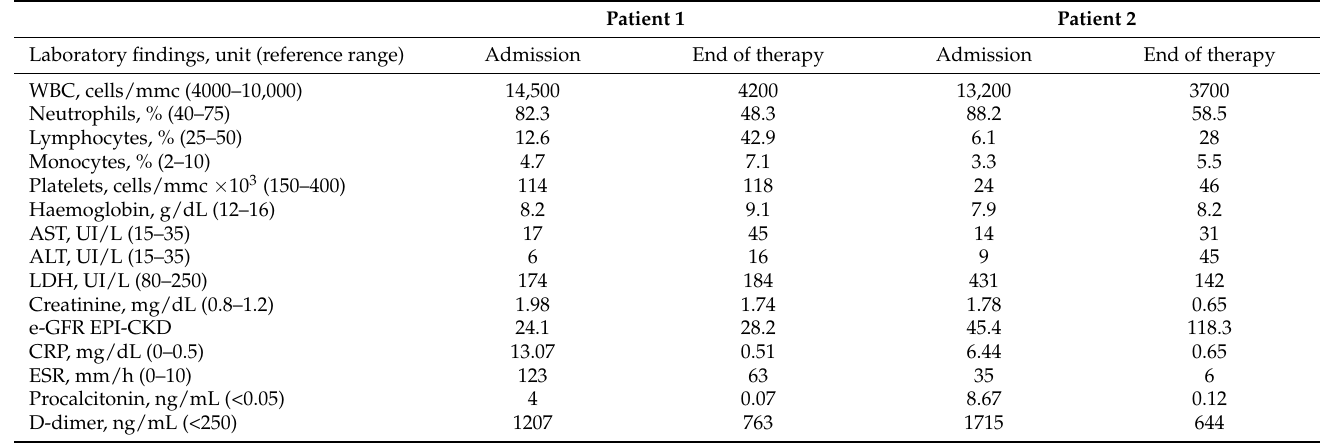
Table 1. Laboratory findings at admission and after antibiotic treatment. WBC: White blood cells; AST: aspartate aminotransferase; ALT: alanine aminotransferase; LDH: lactic dehydrogenase; eGFR: estimated glomerular filtration rate; CRP: C-reactive protein; ESR: erythrosedimentation rate.